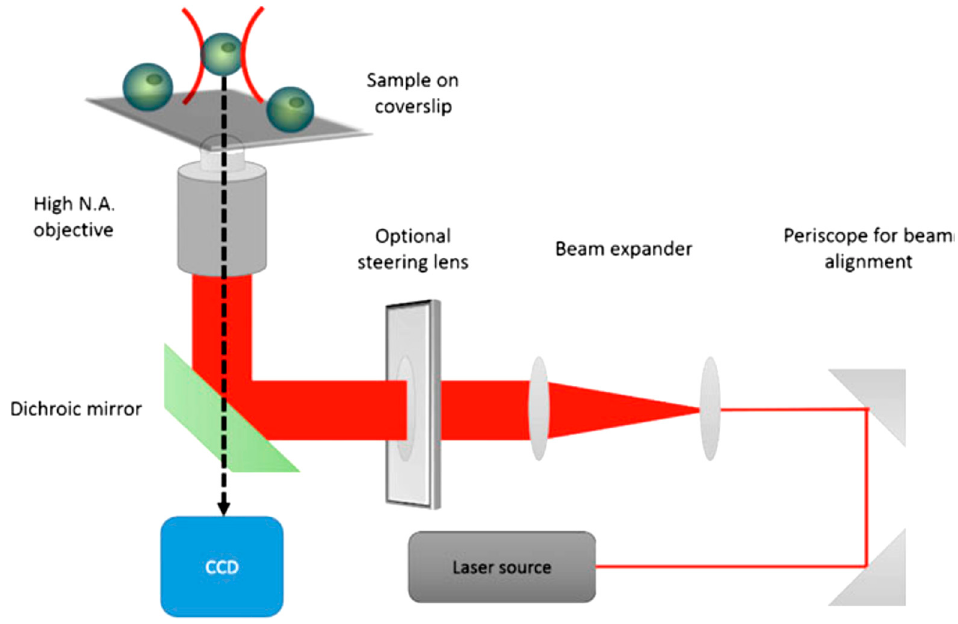
Figure 11. Schematic diagram of optical tweezers used to manipulate single cells. Reprinted with permission from [91]. Copyright (2016) Springer Nature.